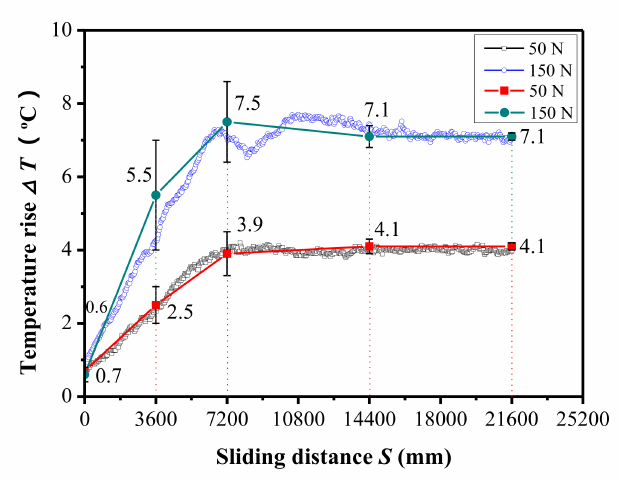
Figure 8. The evolution of temperature rise under different contact loads ( x : 20